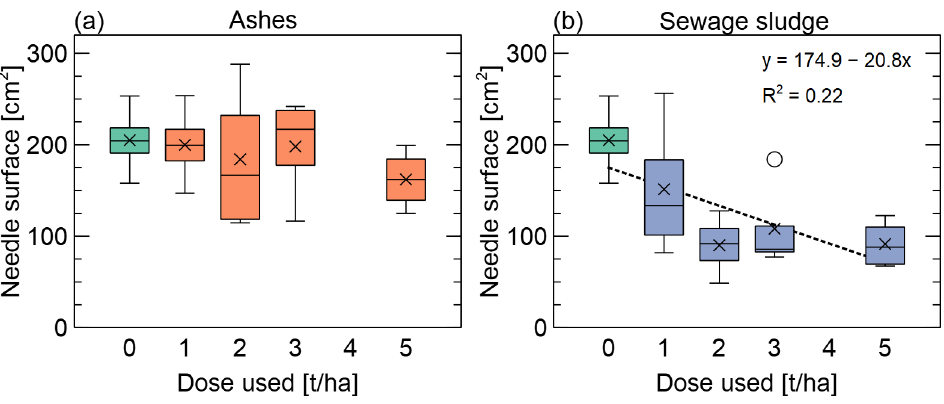
Figure 6. Changes in the needle surface of Scots pine seedlings versus preparation doses. Two studied variants of mixture with ashes ( a ) and sewage sludge ( b ) are presented. The dashed line represents the linear regression fits of the data. The regression equation with the fitted parameters and the model’s R 2 value is printed in the subfigure. The results of regression analysis are presented only for the case when the regression parameters are statistically significant at p < 0.05. In the plot, boxes span from 1st to 3rd quantile, with the median indicated by a line, whiskers indicating 1.5 inter-quantile range, the × symbol mean value, and circles outlier observations.